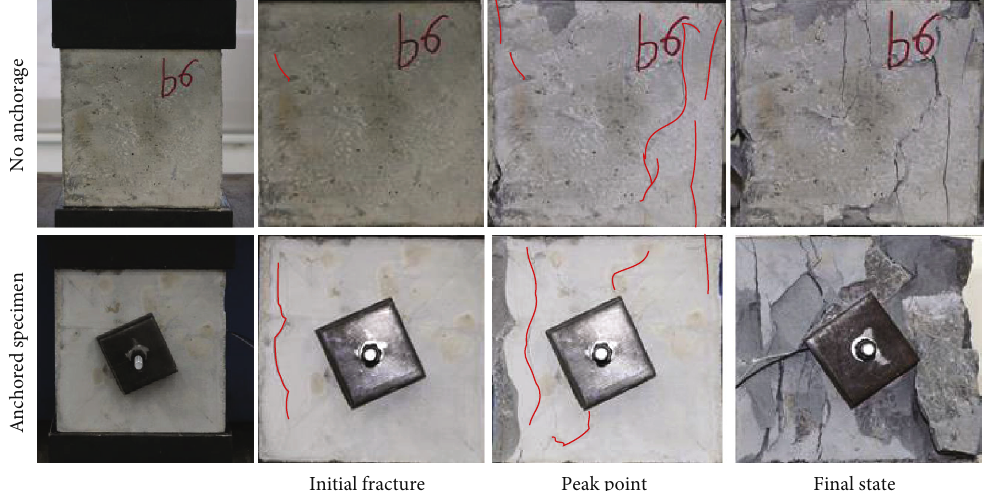
Figure 4: Fracture process of rock mass specimen during uniaxial compression.